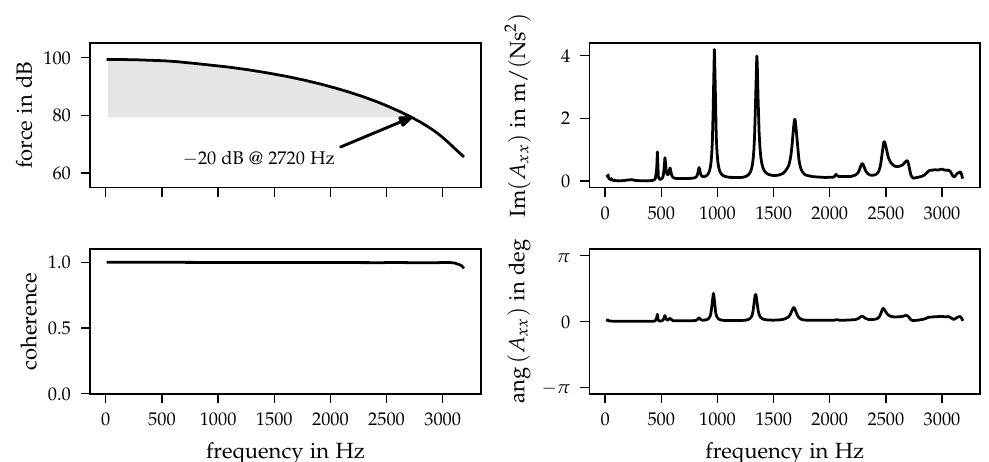
Figure 5. Measurement results of a single example position with a preload of 51N. ( left ) Force spectrum (dB reference F 0 = 1 10 − 6 N) and coherence function. ( right ) Imaginary part and phase · of